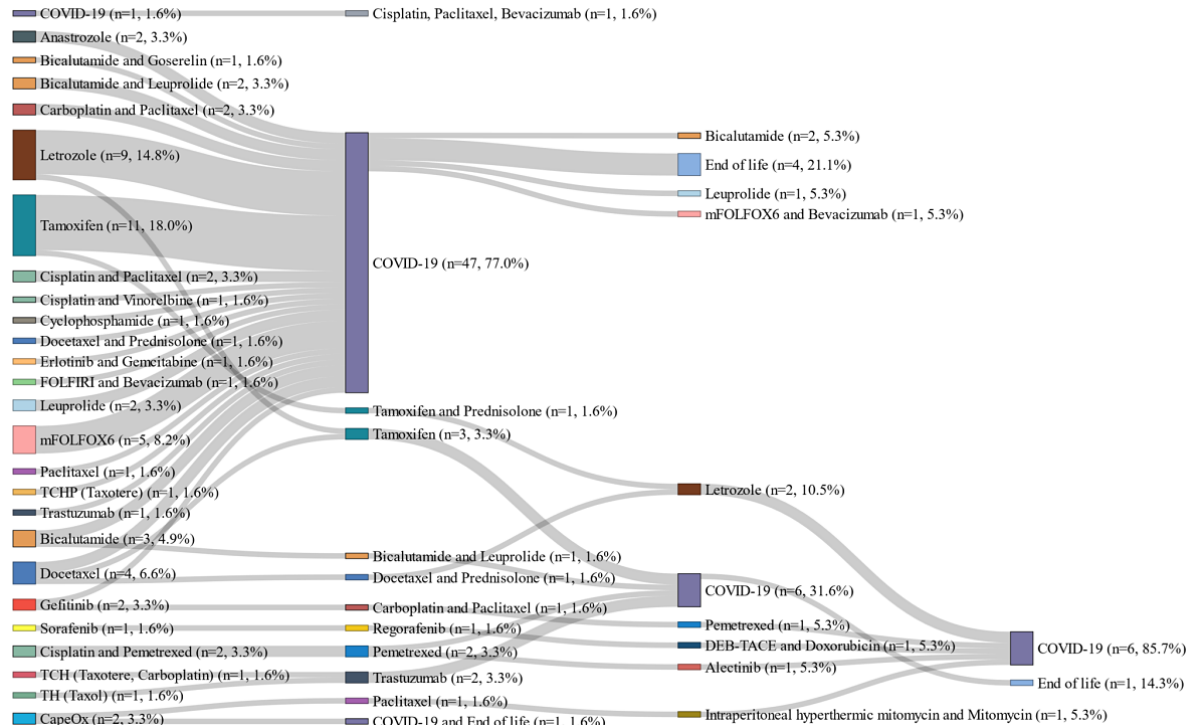
Figure 6. Anticancer treatment trajectories of patients with COVID-19. Sankey plot of the treatment trajectories of patients with COVID-19, including episodes of anticancer chemotherapy between 2017 and 2020. Each node represents the chemotherapy regimen used for cancer treatment. The percentage on the label covers the proportion of the patient number in each node in the same trajectory phase. As the large number of nodes hinders the purpose of the visualizations within a graphical summary, the nodes are truncated at the fourth node. For the same reason, the nodes for patient count <5 were